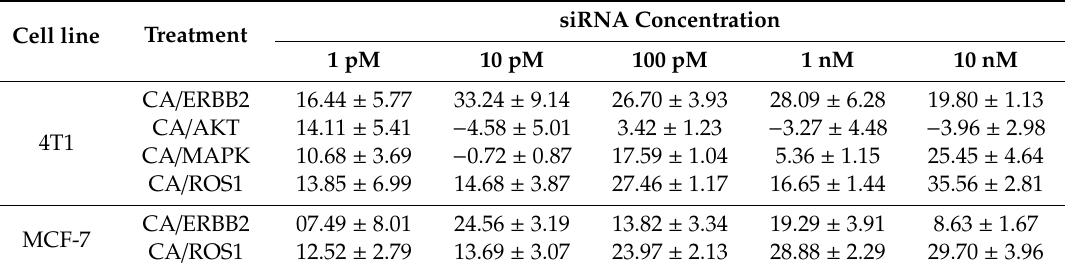
Table 4. Cytotoxicity (%) enhancement on 4T1 and MCF-7 cells treated with various siRNAs (1 pM, 10 pM, 100 pM, 1 nM, and 10 nM) incorporated into an apatite structure formed with 3 mM of CaCl 2 . The data is presented as mean ± SD compared to free siRNA. siRNA Concentration Cell line Treatment 1 pM 10 pM 100 pM 1